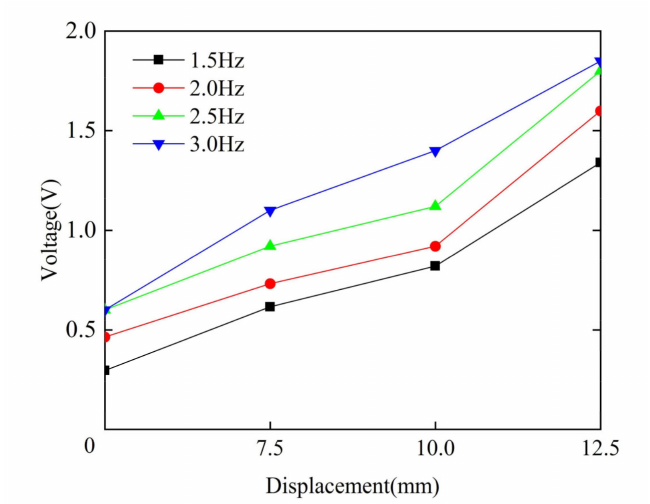
Figure 19. Variation of instantaneous voltage amplitude with frequency under different amplitudes.